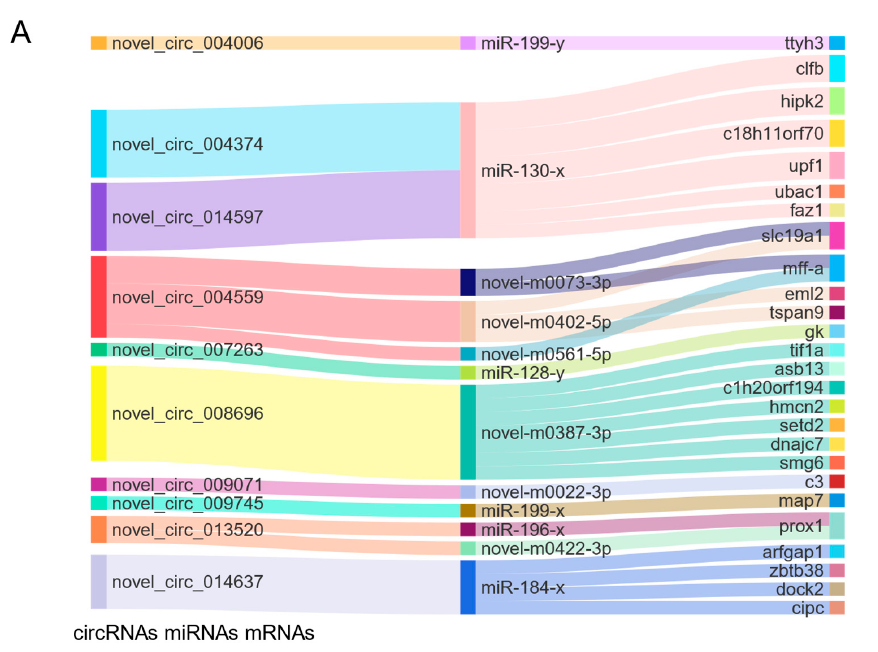
Figure 5. Functional circRNA–miRNA–mRNA regulatory module and the different expression of circRNAs in males, females, and pseudo males. ( A ) The circRNAs, miRNAs, and mRNAs are on the left, middle, and right, respectively. ( B ) Heatmap of the different expression of circRNAs in gonads, brains, muscles, and livers of males, females, and pseudo males. 3.5. Biological Functions of ceRNAs-Relevant mRNAs In order to predict the potential functions of DE circRNAs, GO and KEGG pathway analysis for the ceRNAs-relevant mRNAs were performed. GO analysis of ceRNAs-asso- ciated mRNAs revealed that they were represented in metabolic, development, and others biological processes (Figure S2A). KEGG pathway enrichment showed that the ceRNAs- associated mRNAs were involved in cellular senescence, mRNA surveillance pathway, metabolic pathways, and other pathways (Figure S2B). 4. Discussion Chinese tongue soles have a female heterogametic (WZ female, ZZ male) sex chro- mosome system and show obviously female-biased SSD[15]. As an important regulator for gene expression[53], circRNAs have been identified to be implicated in myogenesis, skeletal muscle and fat tissue growth, follicle development, and sperm motility [54–57]. Herein, we identified the different expression abundances of circRNAs in males, females, and pseudo males to examine the potential roles of circRNAs in C. semilaevis SSD.